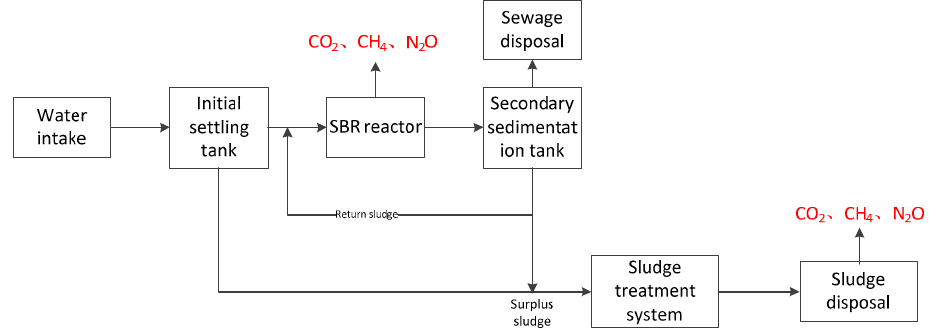
Figure 5. Process flow chart of sequential ‐ batch activated sludge method.